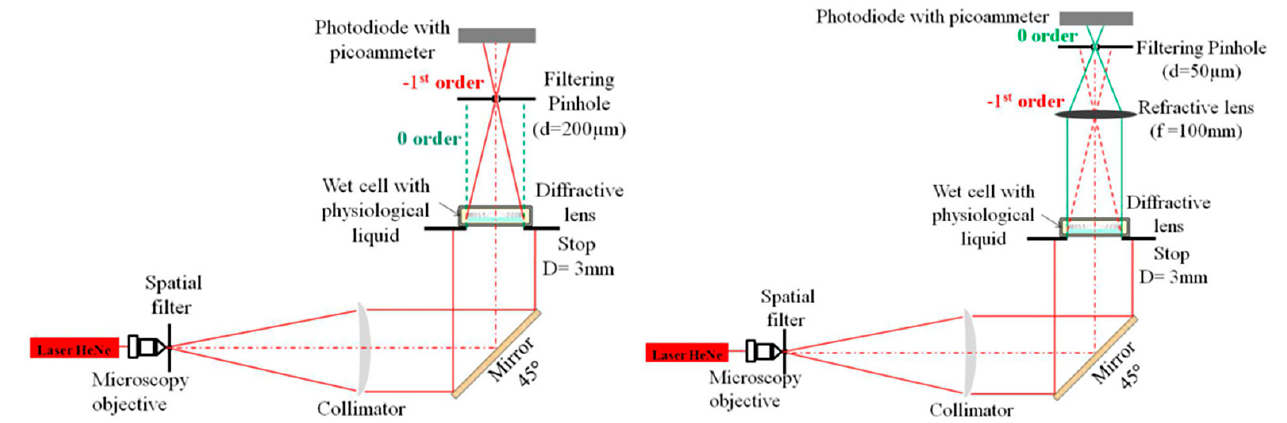
Figure 15. Setup to measure the 1st ( left ) and 0th ( right ) order diffractive efficiency. The 0th order remains collimated behind the diffractive lens and is brought to focus by using an additional convergent lens of 100 mm focal length ( right ), which has a high Strehl ratio (98%). The Strehl ratio S is a suitable figure of merit, defined as the normalized peak intensity of the PSF of the lens: S = I real (0,0)/I ideal (0,0) = | ∫∫ e ik ψ (x,y) dxdy| 2 where I real (0, 0) and I ideal (0, 0) denote the intensities at the center of the real point image and the ideal point spread function (PSF) without aberrations, respectively [19]. Figure reprinted from Ref. [82] under the terms of the Creative Commons Attribution License 4.0.